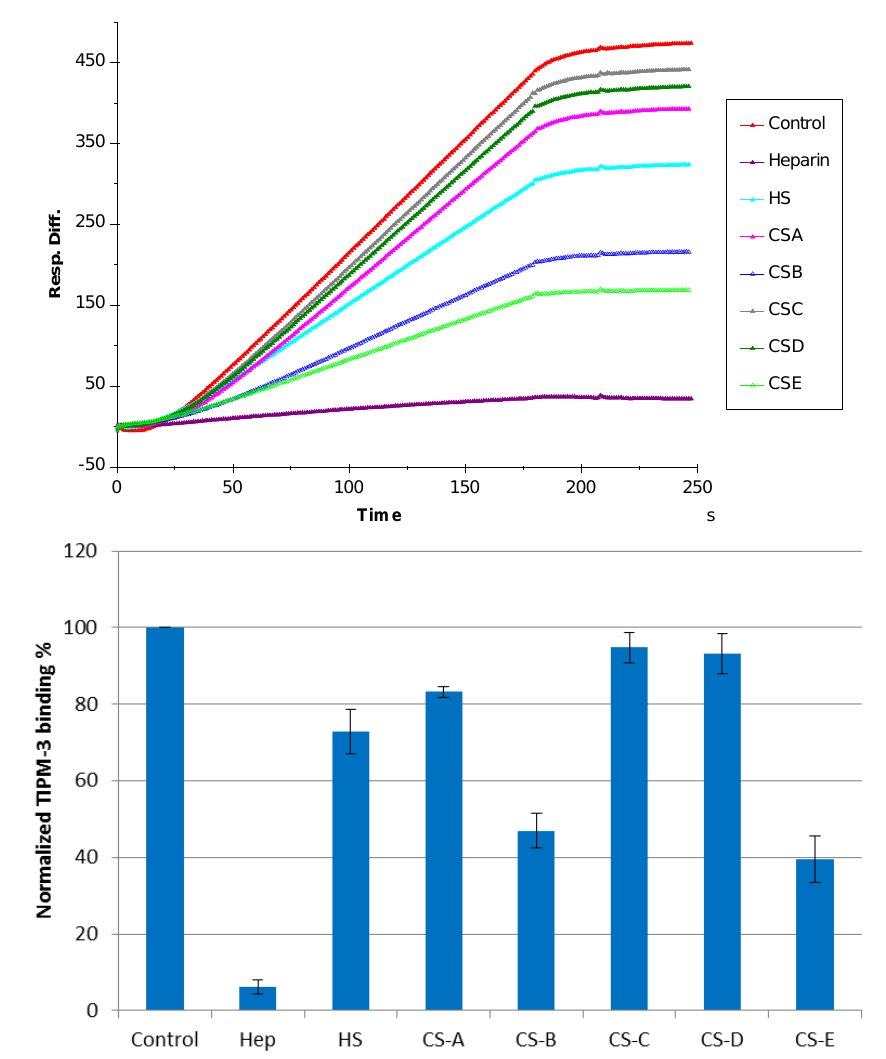
Figure 5. ( Top ): Sensorgrams of solution GAGs/surface heparin competition. TIMP-3 concentration was 10 nM, and concentrations of GAGs in solution were 100 nM. ( Bottom ):